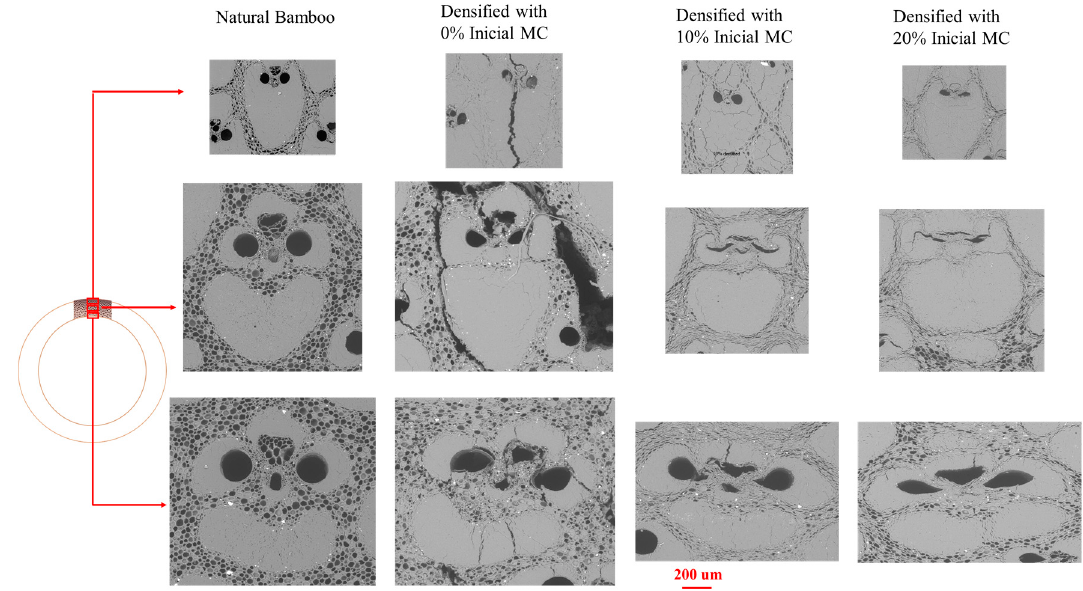
Figure 20. Scanning electron microscope (SEM) images of the non-densified and densified samples in different initial MC (from 0% up to 20%).